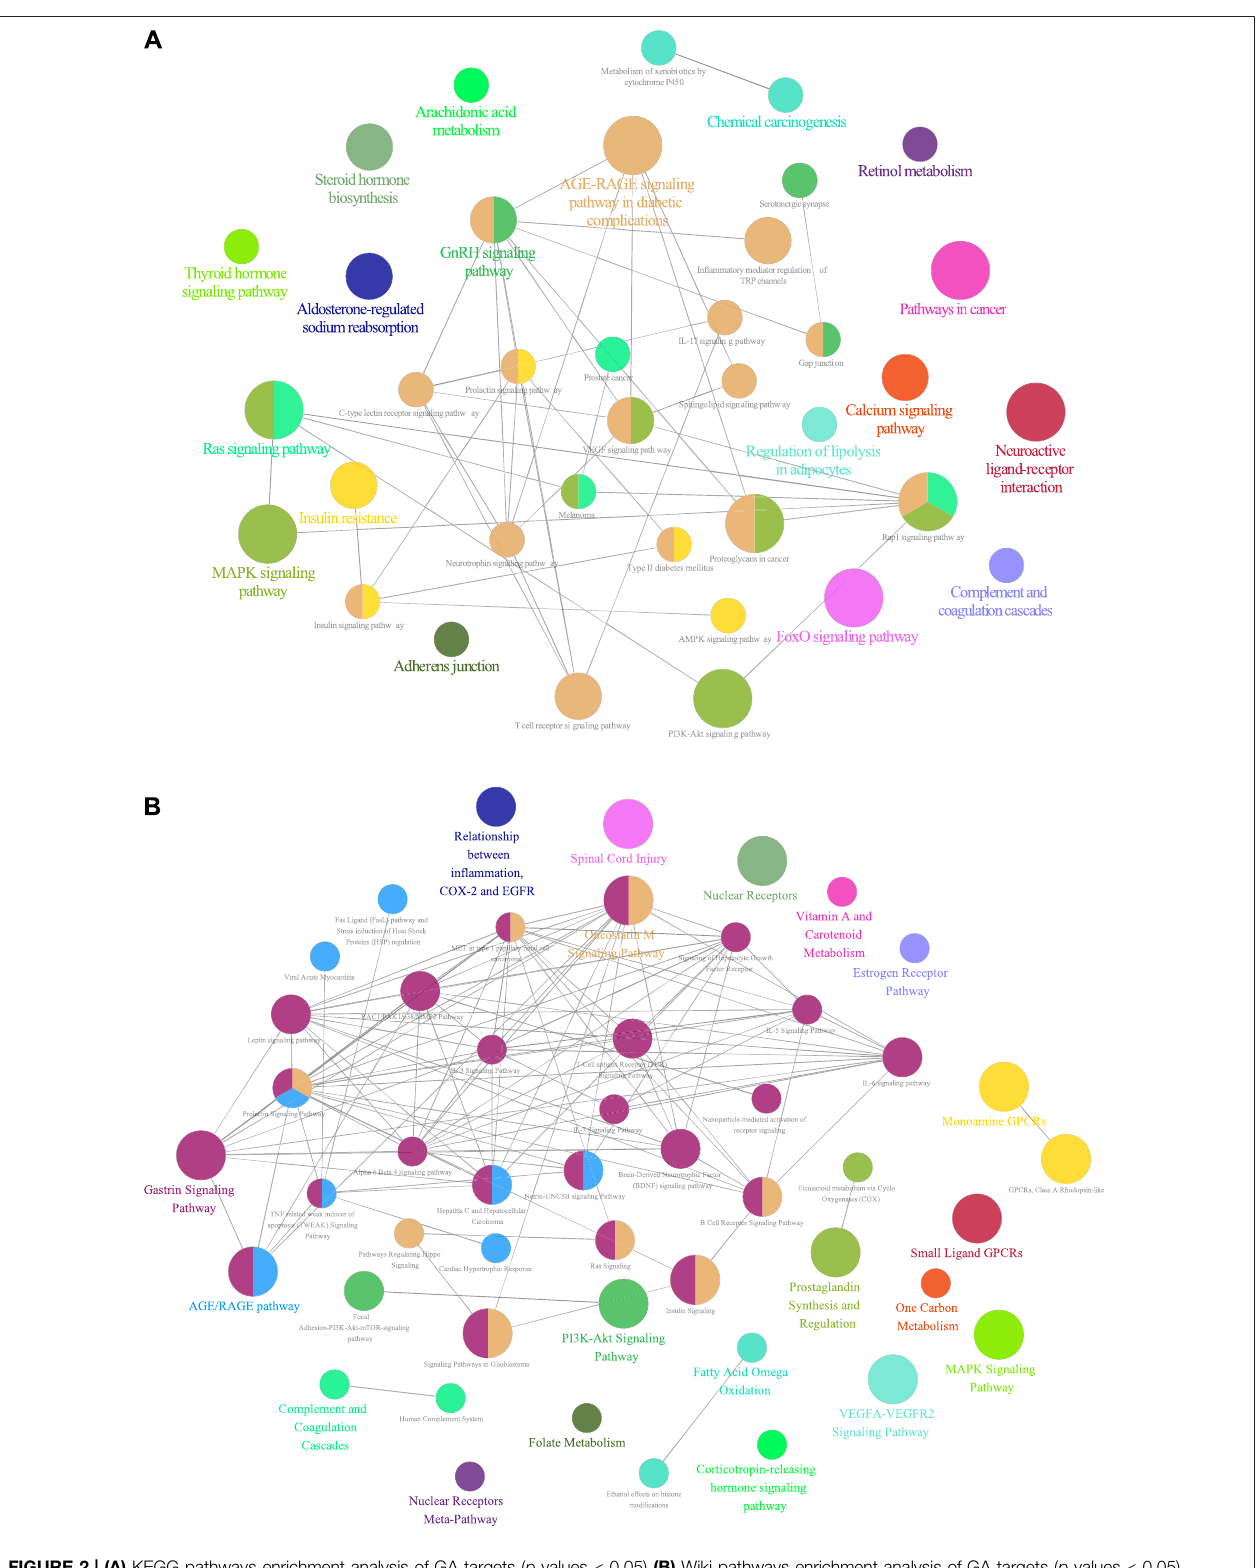
FIGURE 2 | (A) KEGG pathways enrichment analysis of GA targets ( p values < 0.05) (B) Wiki pathways enrichment analysis of GA targets ( p values < 0.05).